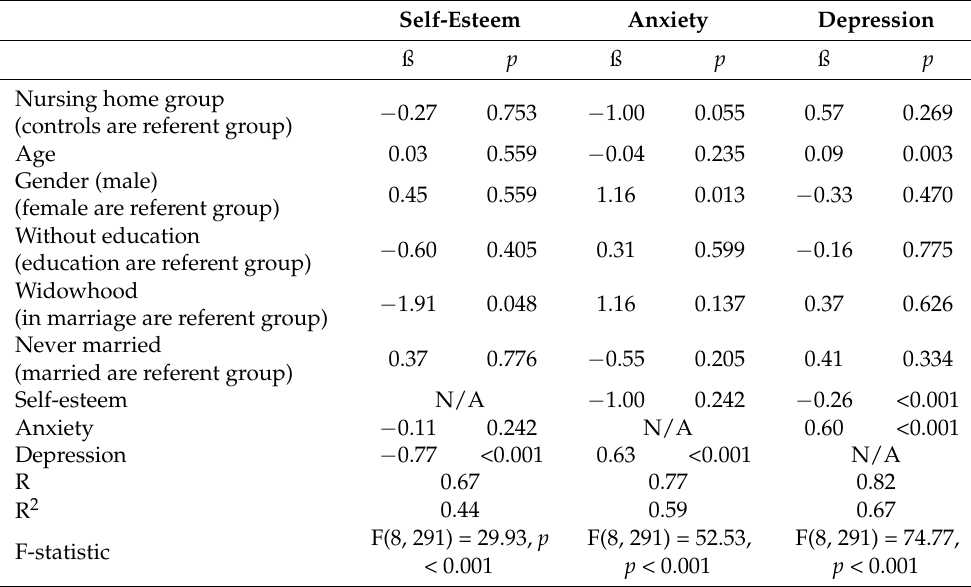
Table 5. Regression analysis for variables predicting self-esteem, anxiety, and